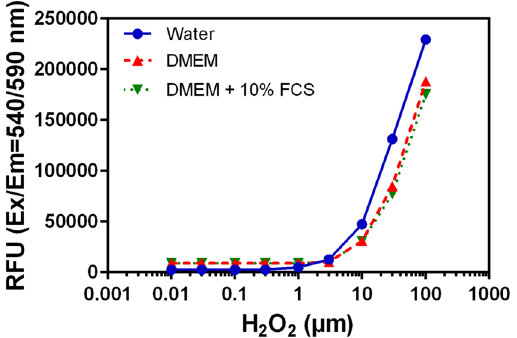
Figure 14. Calibration curves of hydrogen peroxide concentration in three solvents.